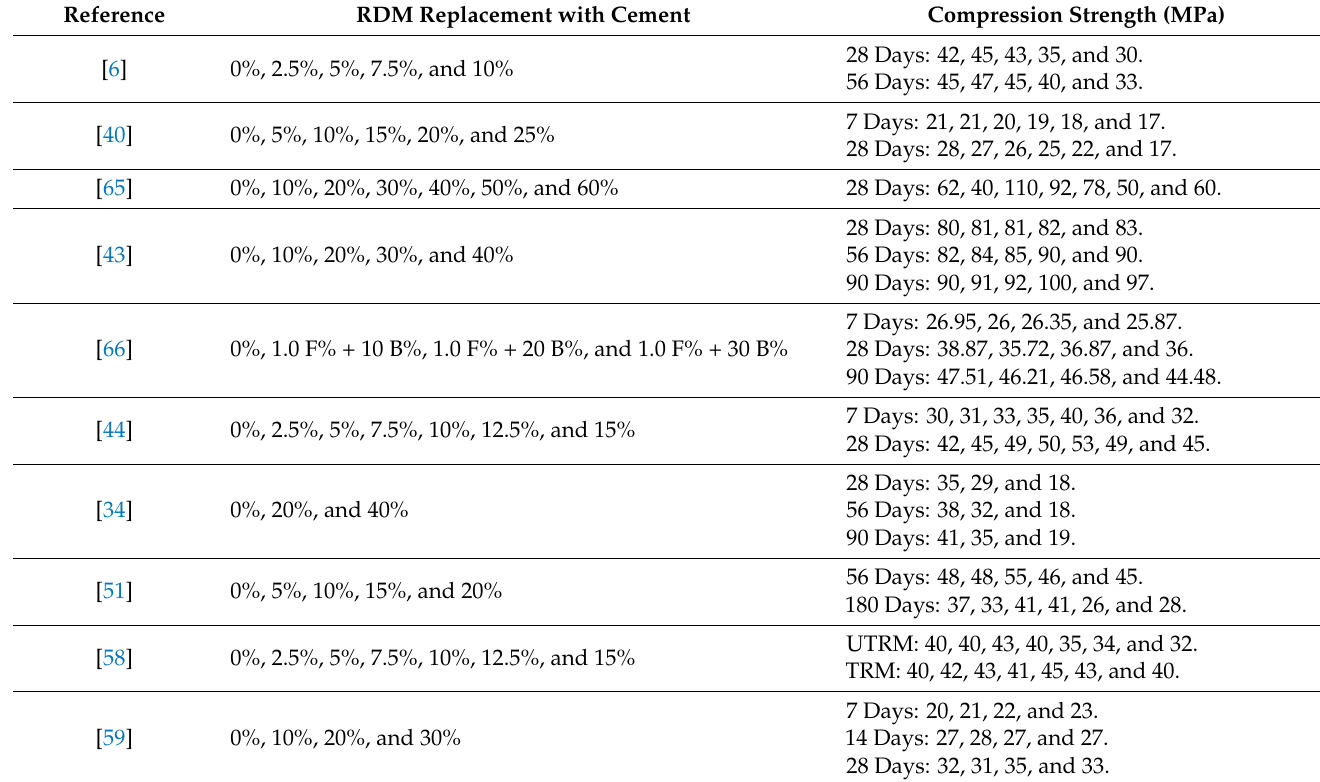
Figure 9. Compressive Strength: Data Source [44]. Table 2. Summary of Compressive